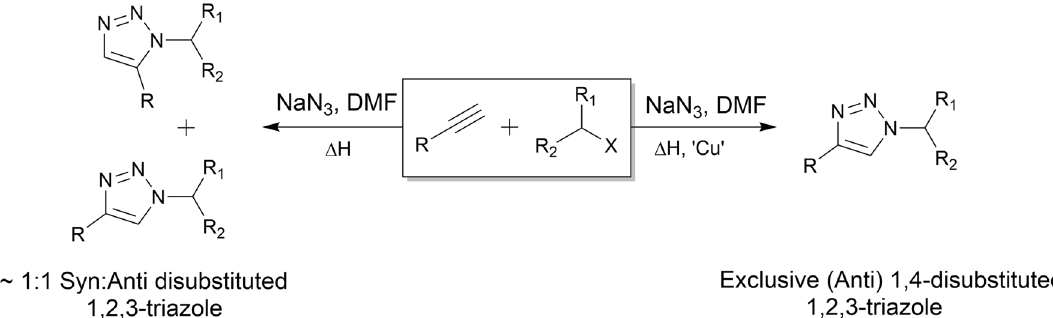
Figure 3. Isomeric outcome of both traditional and copper catalysed Huisgen cycloadditions. The Cu(I) catalysed Huisgen cycloaddition results in exclusive formation of the 1,4-disubstituted 1,2,3-triazole whilst the thermally induced Huisgen cycloaddition typically yields a 1:1 mixture of 1,4- and 1,5-trizole